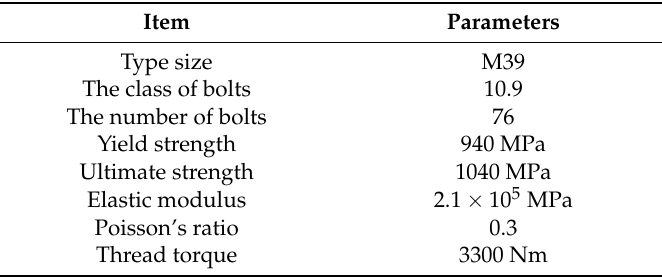
Table 2. Bold parameters.